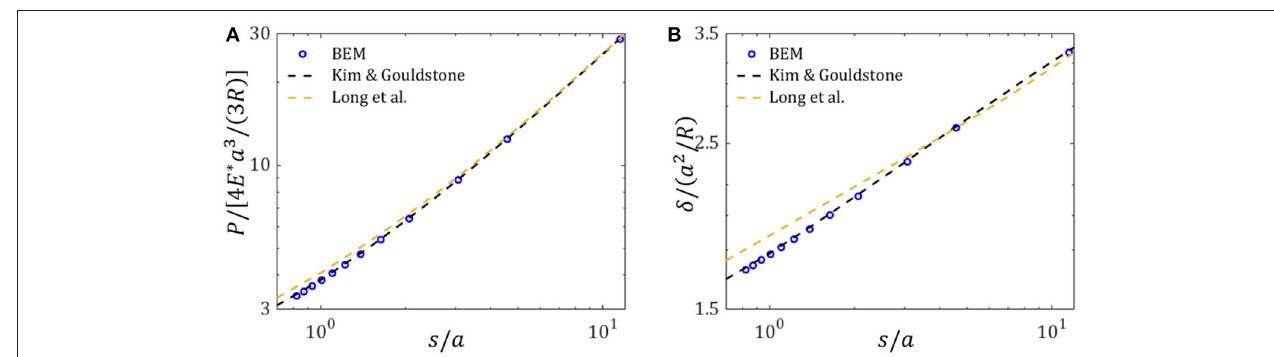
FIGURE 5 | Dependences of contact responses (normalized by the prediction of Hertz theory) on the ratio s / a : (A) indentation load; (B) indentation depth.